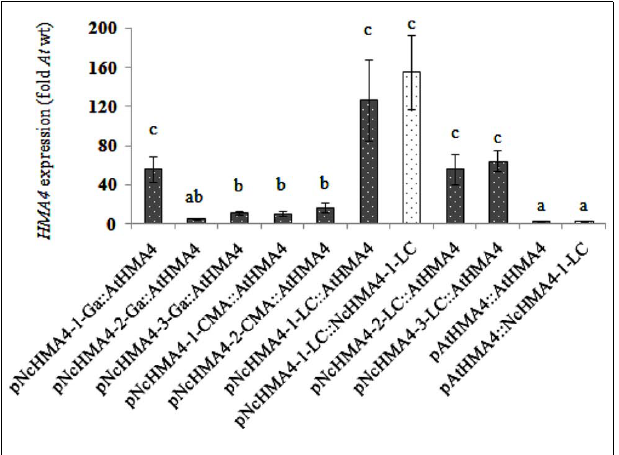
FIGURE 4 | AtHMA4 (solid bars) and NcHMA4-1-LC (open bars) expression under A. thaliana and N. caerulescens promoters in the shoot of transgenic A. thaliana relative to the expression in the shoot of A. thaliana wild-type which is considered as 1 (means of 5 plants ± SE) . Significant differences ( P < 0.05) between means are indicated by different superscripted letters.